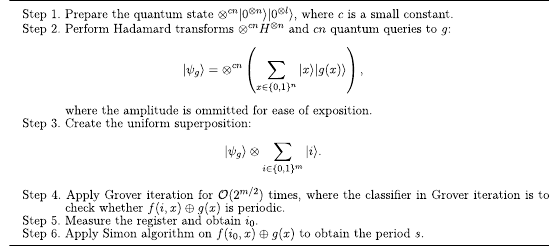
Algorithm 4. Of fl ine Simon algorithm